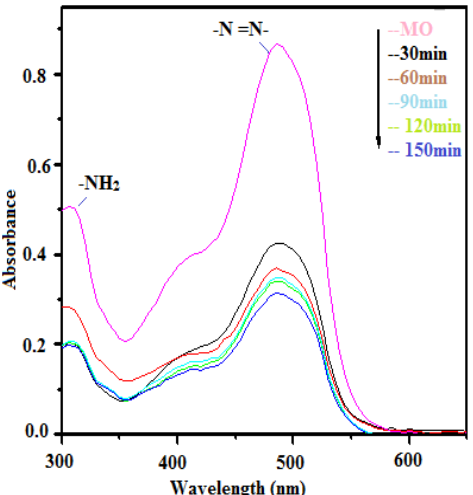
Fig. 6. Effect of irradiation time on Methyl Orange dye